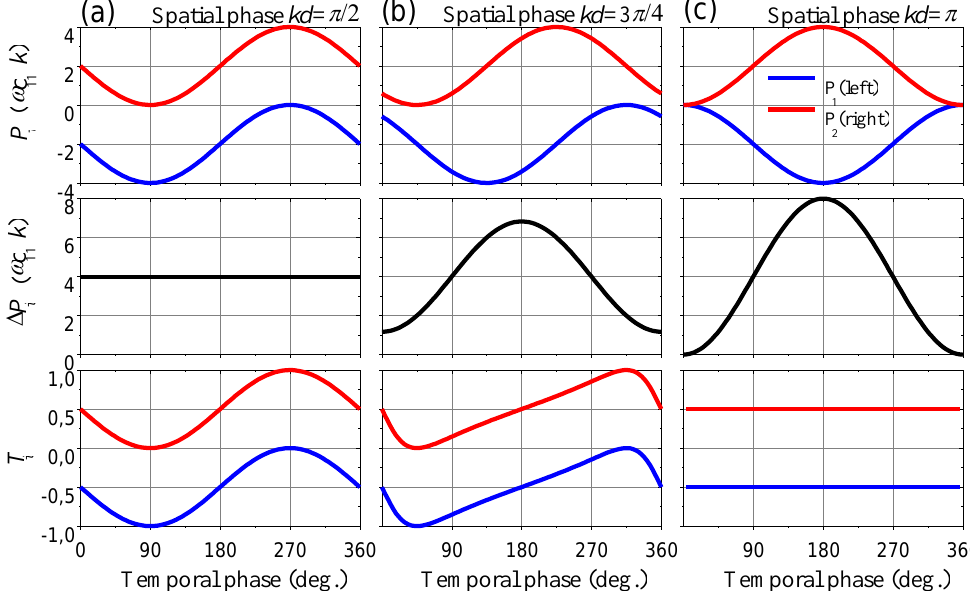
Figure 1. Energy flux ( P i ), power consumption ( ∆ P i ), and relative outputs ( T i ) at ports P 1 (blue) and P 2 (red) for two sources S 1 and S 2 distant of d and placed in a homogeneous nanobeam, for a wave vector k as a function of the temporal phase for three spatial phases: π /2 ( a ), 3 π /4 ( b ) and π ( c ).